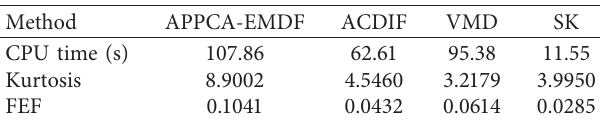
Table 6: The comparison results of APPCA-EMDF, ACDIF, VMD, and SK methods in simulation case 2. Method